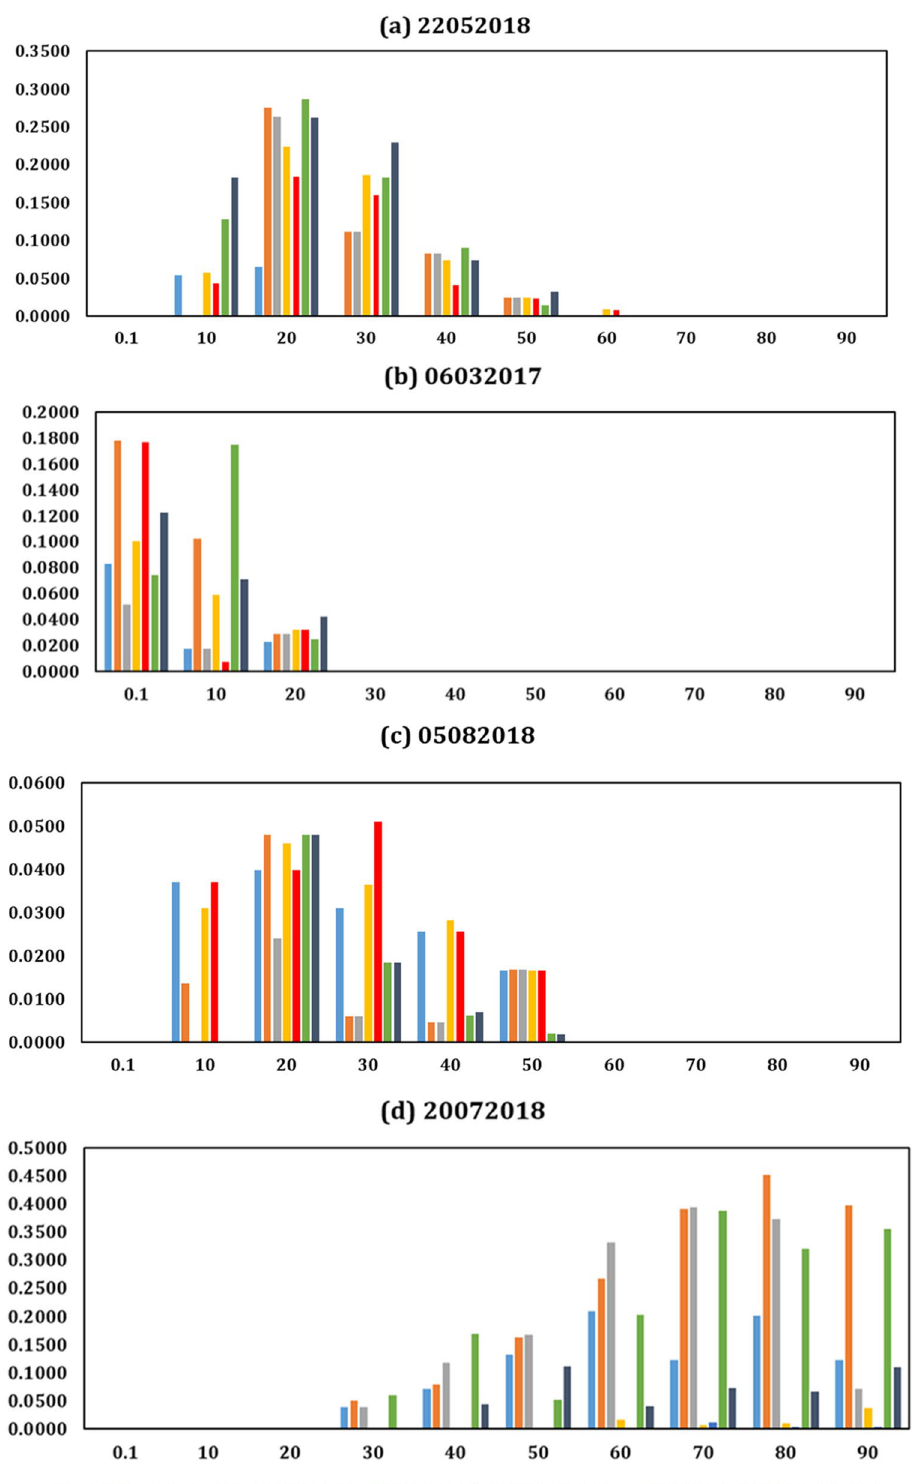
Fig. 6 Heidke Skill Score of rainfall of a 22052018, b 06032017, c 05082018 and d 20072018